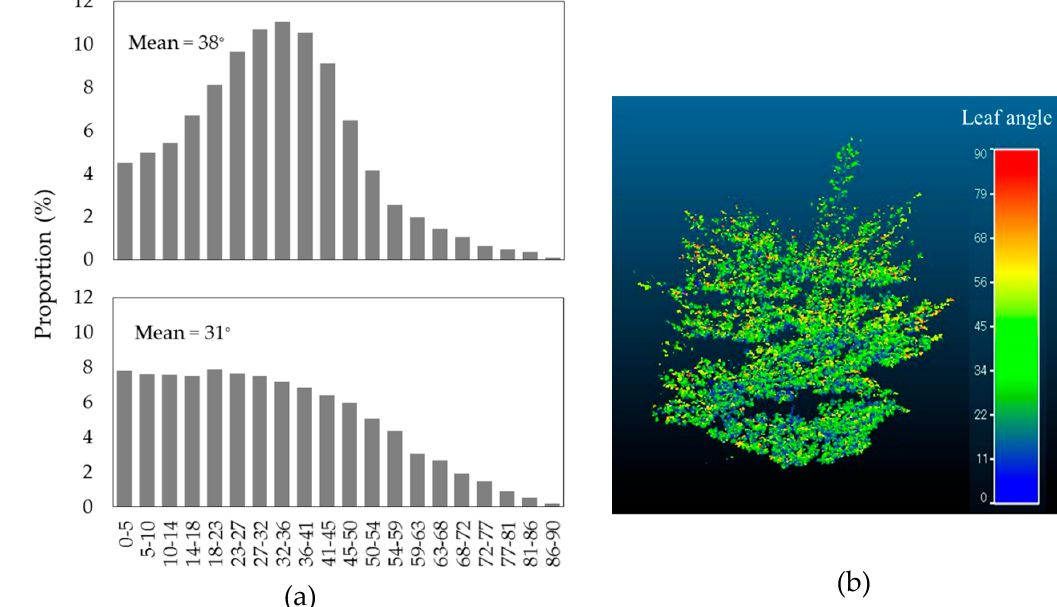
Figure 10. Leaf angle distribution in the mochi tree: ( a ) LAD graph for the tree’s top (3–1.5 m) and bottom (1.5–0 m); ( b ) LAD image of the whole tree.